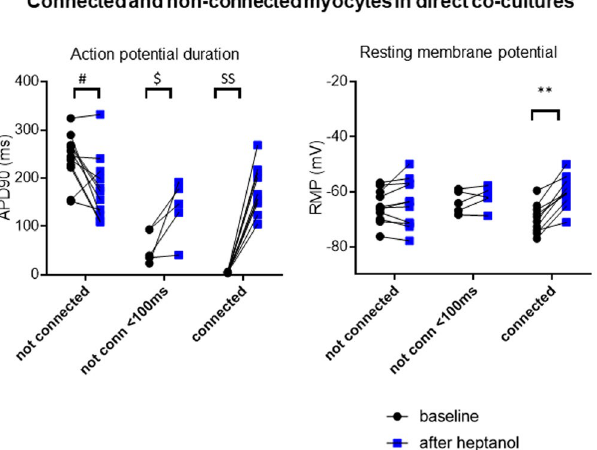
Figure 7. Heptanol prolongs action potential in CMs coupled to MyoFbs. Pooled data from 8 co-cultures of CMs with MyoFbs (spontaneously differentiated or TFG β 1-treated), showing paired data before and after heptanol treatment. CMs were categorized based on the change in capacitance after heptanol as not connected (n = 11), not connected but with short APD (n = 5), or connected (n = 10). In the first group, APD overall shortened ( # p = 0,01318), in the second group APD prolonged ( $ p = 0.03980) and in the third group as well ( $$ p < 0.00001). For the RMP, only the third groups had a statistically significant depolarization ( ** p =